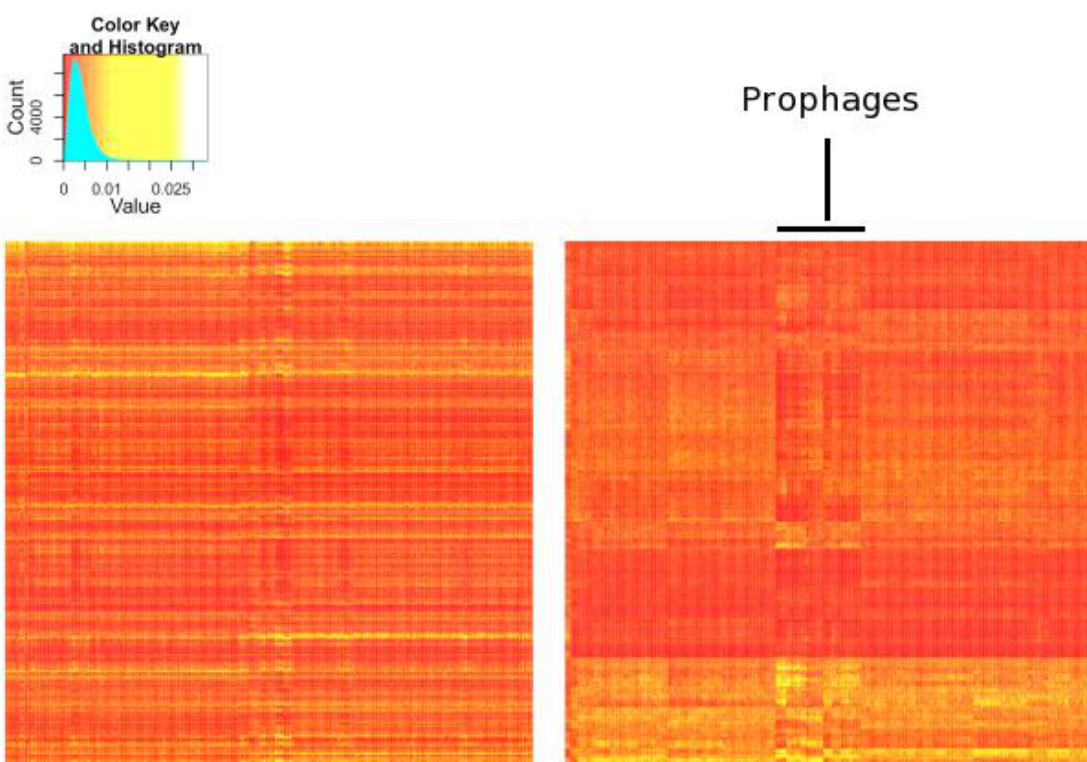
FIGURE 1. Oligonucleotide frequencies distributions within the Bacillus subtilis genome. The graphs show tetranucleotide frequencies (vertical axis) calculated from the first nucleotide to the last (horizontal axis) in the B. subtilis genome using a sliding window of 5 kbp from left to right. On the left graph, the position of the sliding windows is arranged in the sequential order of the genome. On the right graph, the sliding window positions are arranged according to how the tetranucleotide patterns for each sliding window are clustered. The figure clearly illustrates how the visual effect changes within the B. subtilis genome before (left graph) and after (right graph) clustering. It has been shown previously that the marked regions with the unusual tetranucleotide patterns in the middle on the rightmost figure are prophages. A close inspection of the leftmost graph may indicate that the prophages have been integrated at many different places in the genome; alternatively, that there have been multiple transfers even from the same host. The histogram on top shows the distribution of tetranucleotides in the B. subtilis